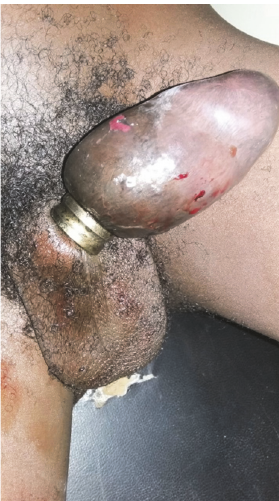
Figure 1: Thick constricting penile ring with grossly swollen penis with skin changes.